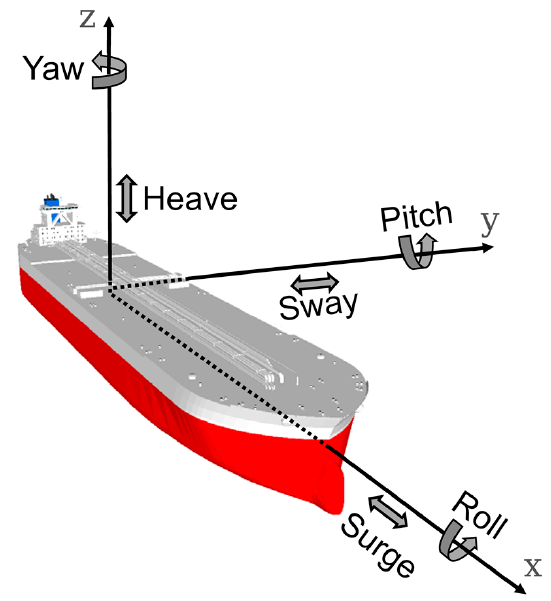
Figure 2. Vessels motions along the three axes.